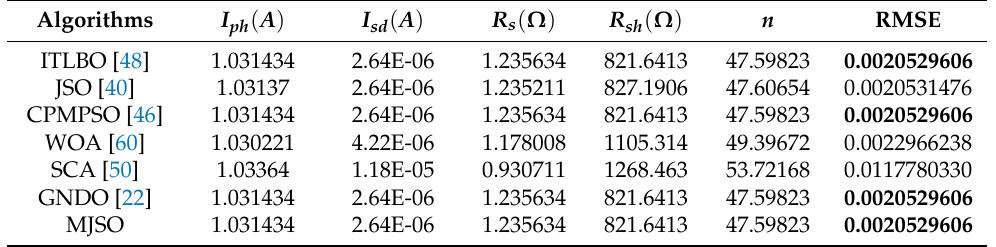
Table 11. Comparison on the Photowatt-PWP201 module.